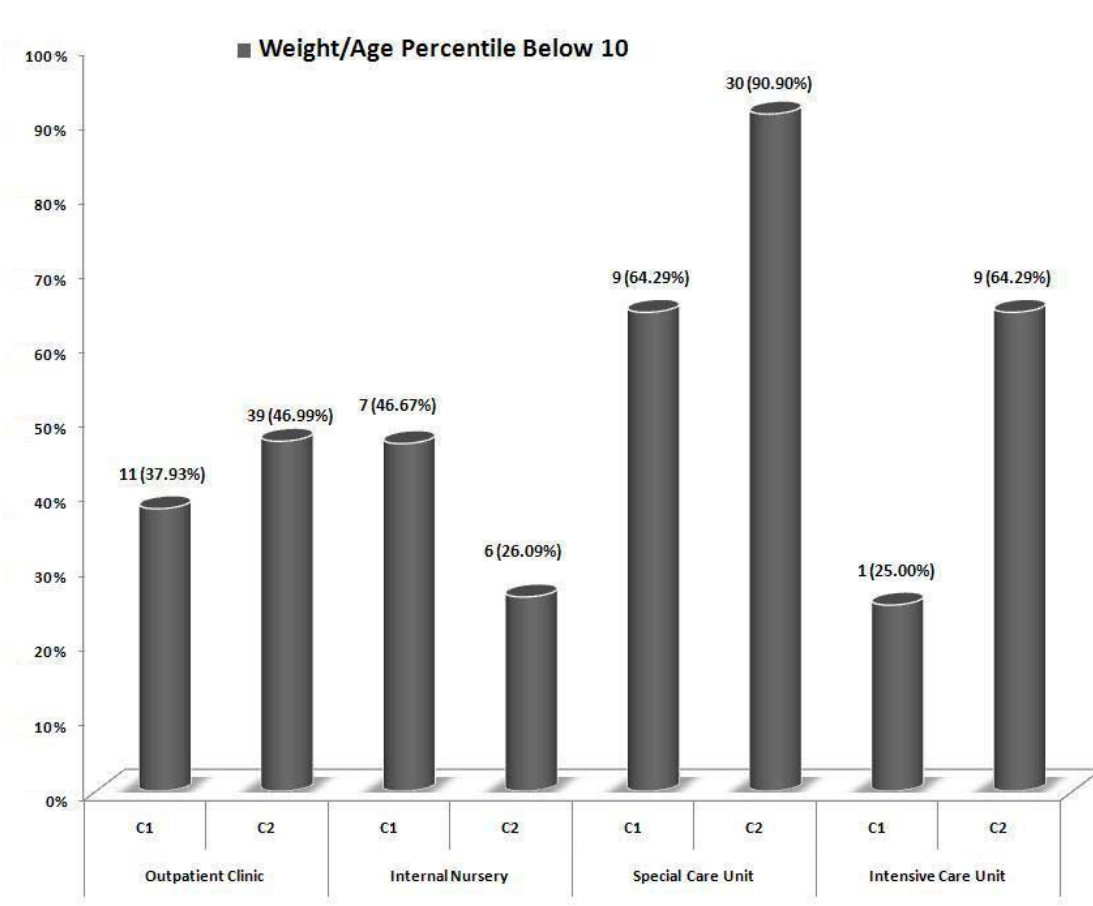
Figure 2. Percentage of children with craniofacial malformations in groups C1 and C2 with weight-for-age percentile below 10 by NCHS, according to the hospital